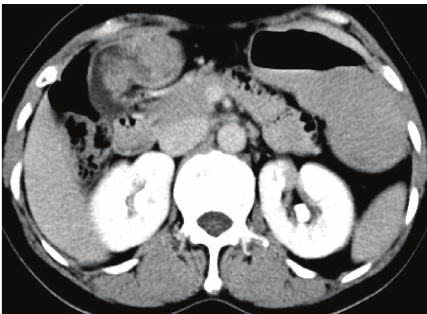
Figure 1: CT scan reveals a thickening gallbladder wall and het- erogeneous enhancement of the gallbladder wall, with the interface between the gallbladder wall and the liver not apparent.